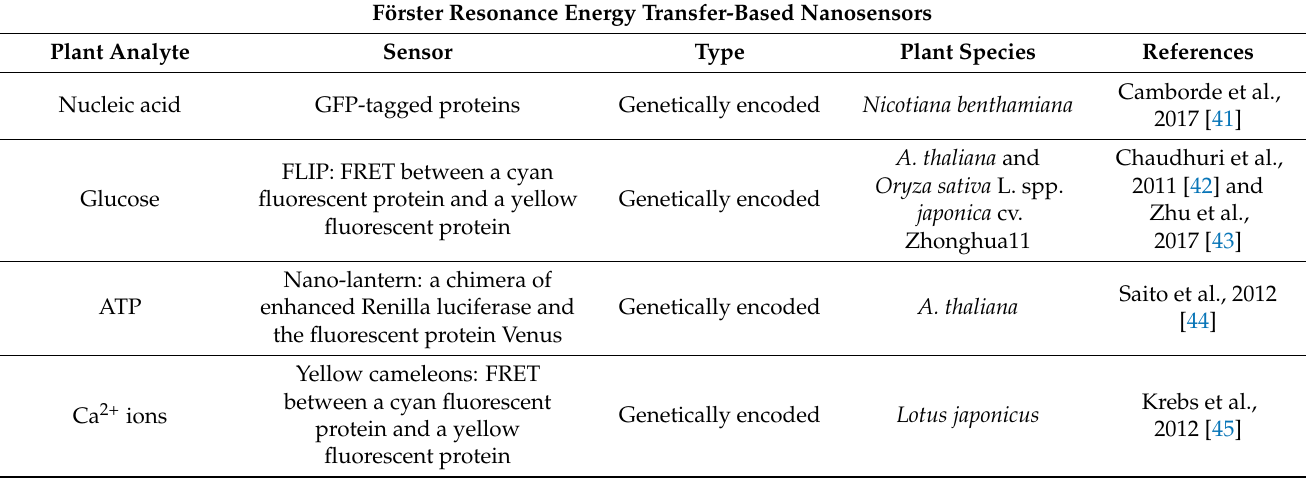
Table 2. Förster resonance energy transfer-based nanosensors and plant